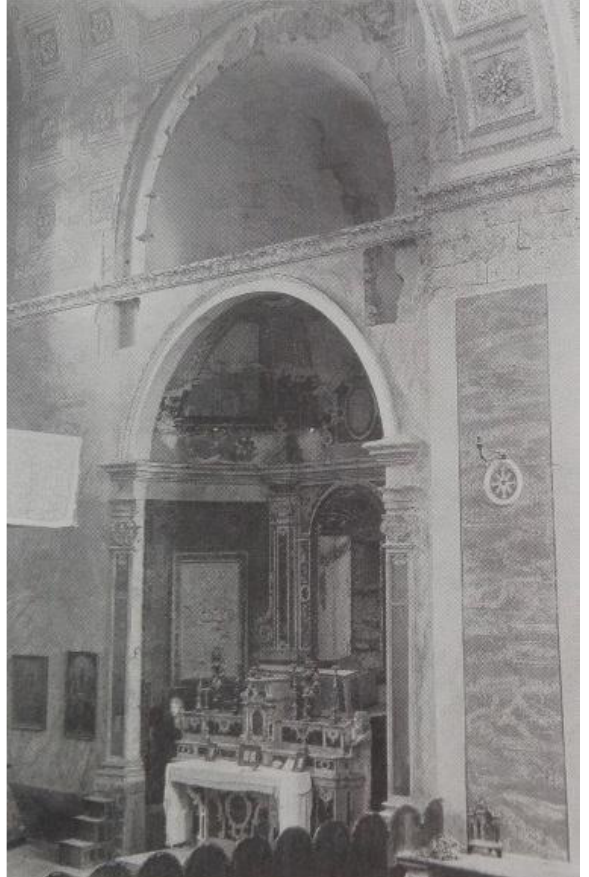
Figure 3. The altar of the Holy Heart of Mary still in situ, before the dismounting, in the left apse of Gerace Cathedral (1934).